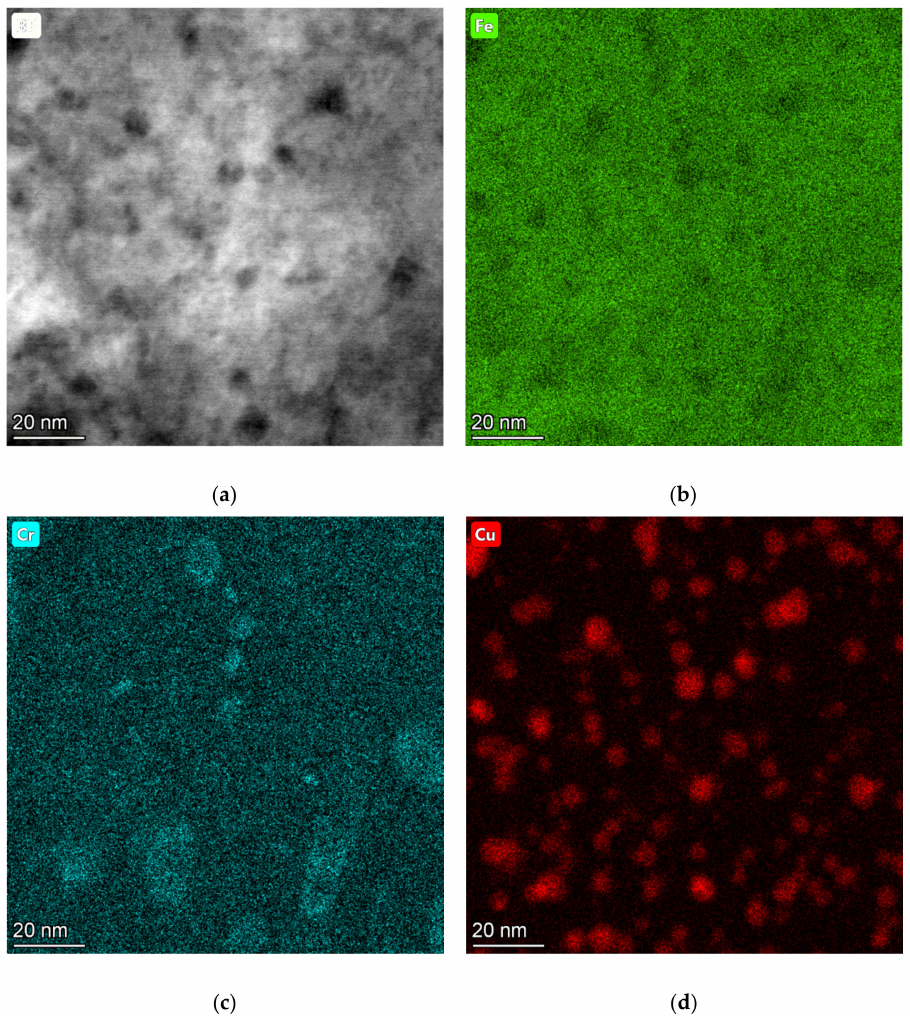
Figure 10. TEM-EDS map of chemical composition showing Cu-rich precipitates after tempering at 500 ◦ C—( a ) BF, ( b ) Fe map, ( c ) Cr map, ( d ) Cu